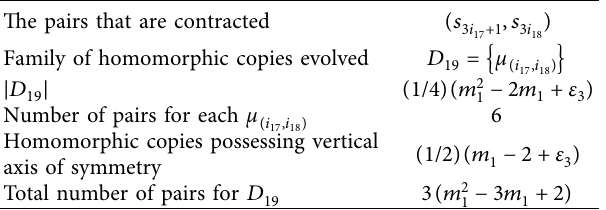
Table 18: Necessary information regarding homomorphic copies